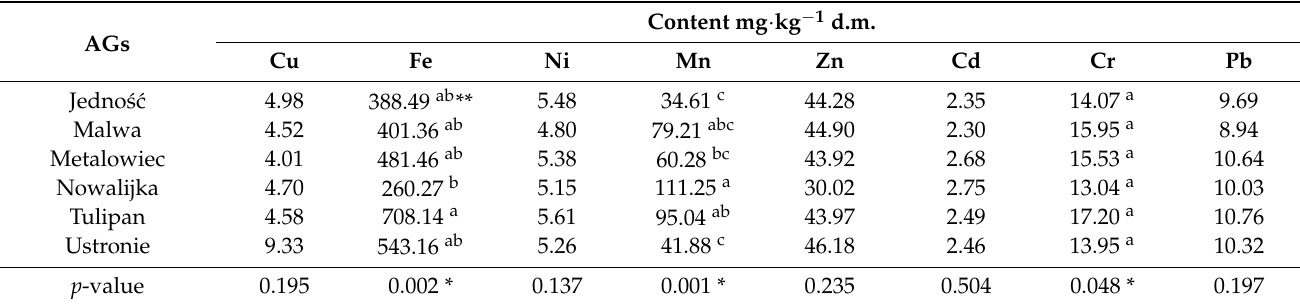
Table 14. The content of heavy metals in the aboveground part of Daucus carota subsp. sativus growing in six allotment gardens of Gorz ó w Wielkopolski.